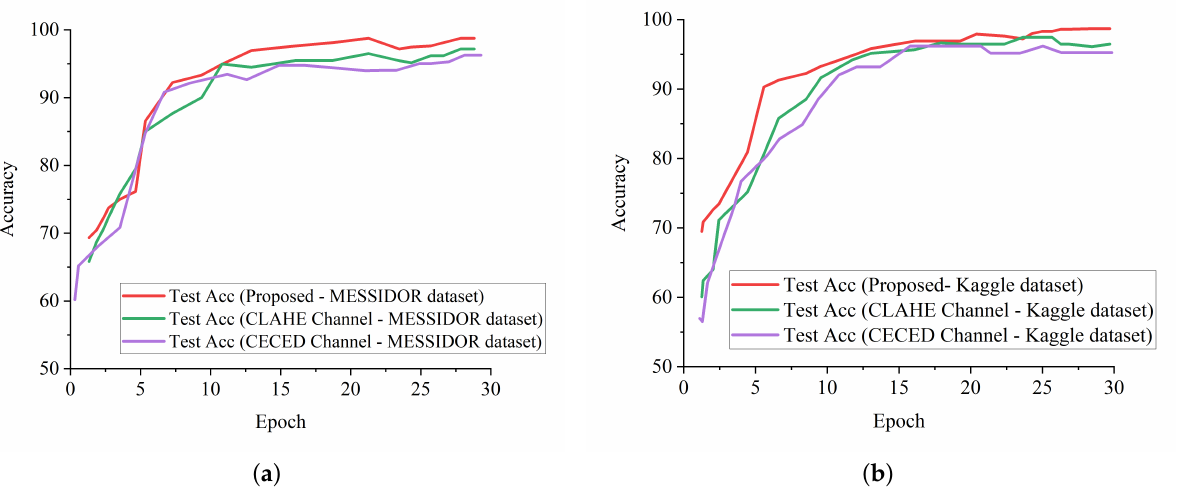
Figure 11. Accuracy performance report of our proposed model and single-channel models on both the Messidor and Kaggle datasets. ( a ) Test accuracy curve for our proposed model in comparison with the single channels on the Messidor dataset. ( b ) Test accuracy curve for our proposed model in comparison with the single channels on the Kaggle